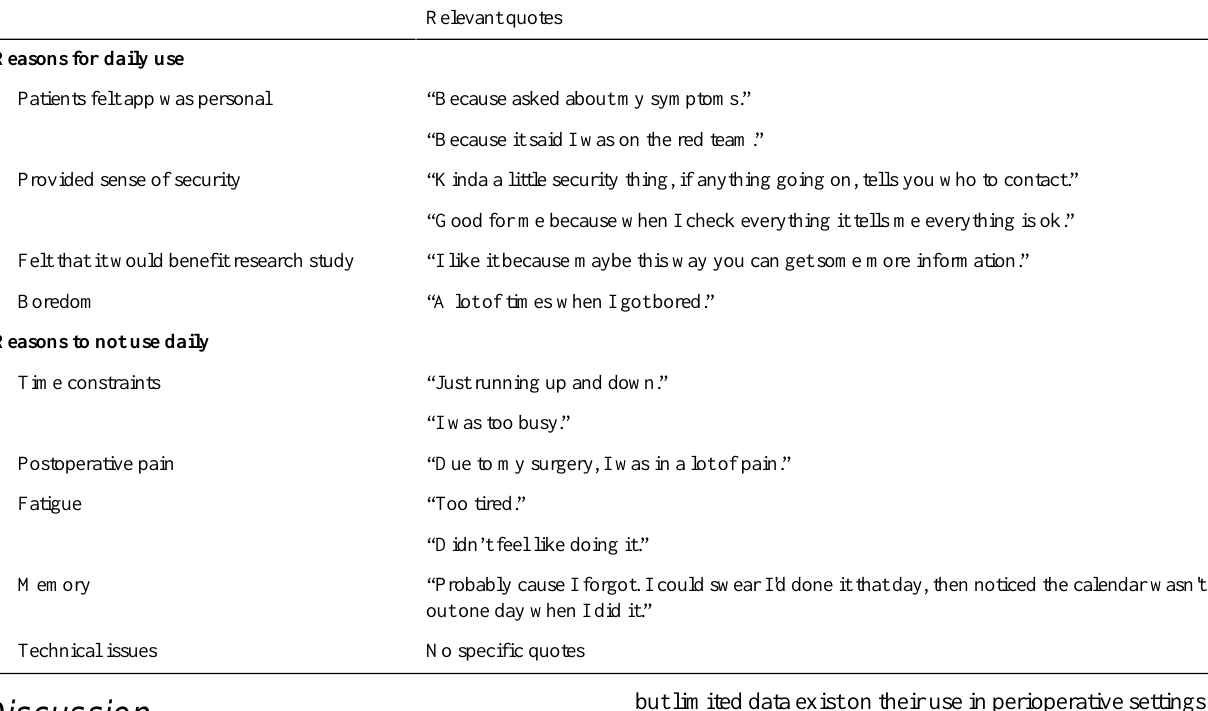
Table 4. Reasons for using/not using the